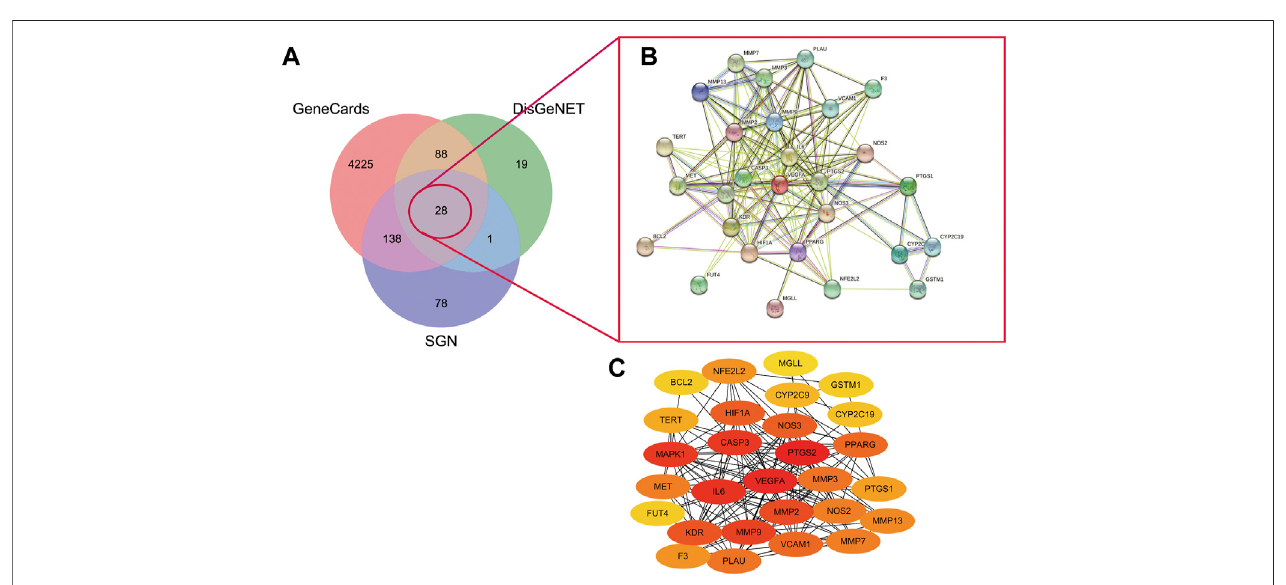
FIGURE 6 | A. Venny diagram of targets of SGN with AGU.B. PPI network of SGN and GU overlap targets C. core targets plot. The redder the color mean more important of the